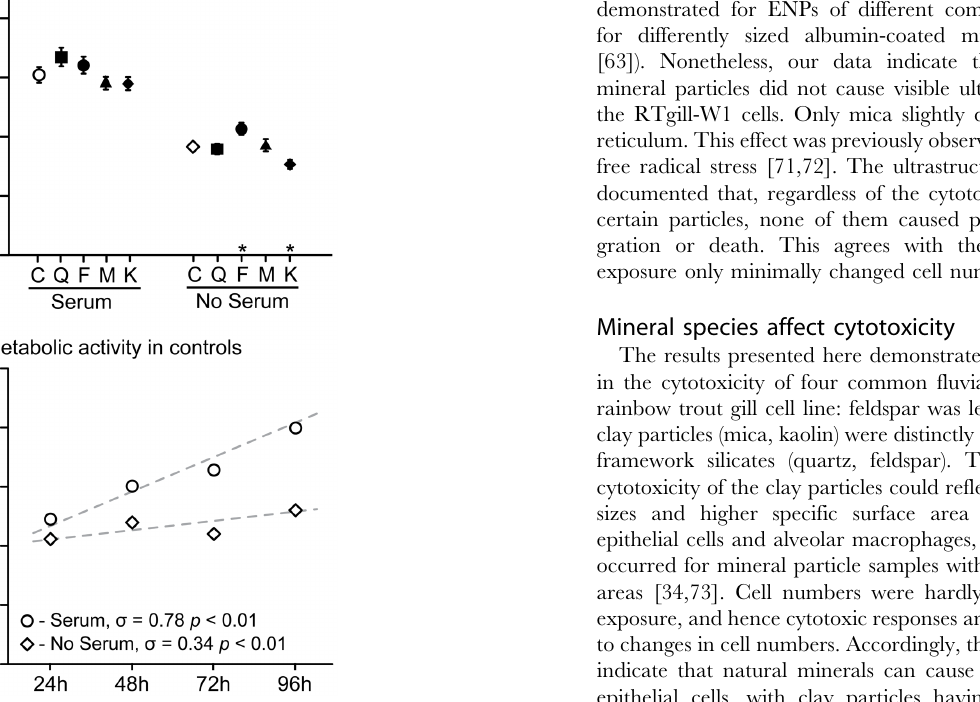
Figure 3. Effects in cell numbers and baseline metabolic activity in control wells. A.) Cell counts after 72 h exposure to 250 mg L 2 1 mineral particles. Shown are exposure with (left group) and without (right group) FBS. Open symbols are controls (C, no particles), and filled symbols denote mineral particle (quartz, Q; feldspar, F; mica, M; kaolin, K). Asterisks near the x-axis denote significant (p , 0.05) differences to respective control; B.) Changes in metabolic activity of controls during the experiment, shown are controls with (circles) and without (diamonds) FBS. Dashed lines are best fit lines with respective Pearson product-moment correlation coefficients ( s ) given near the x- axis. In both graphs data points are mean 6 SE. Note: Summary statistics shown in A.) were calculated from raw-data, while significance was tested with a generalized linear mixed-effect model to adjust for clustering of the wells on